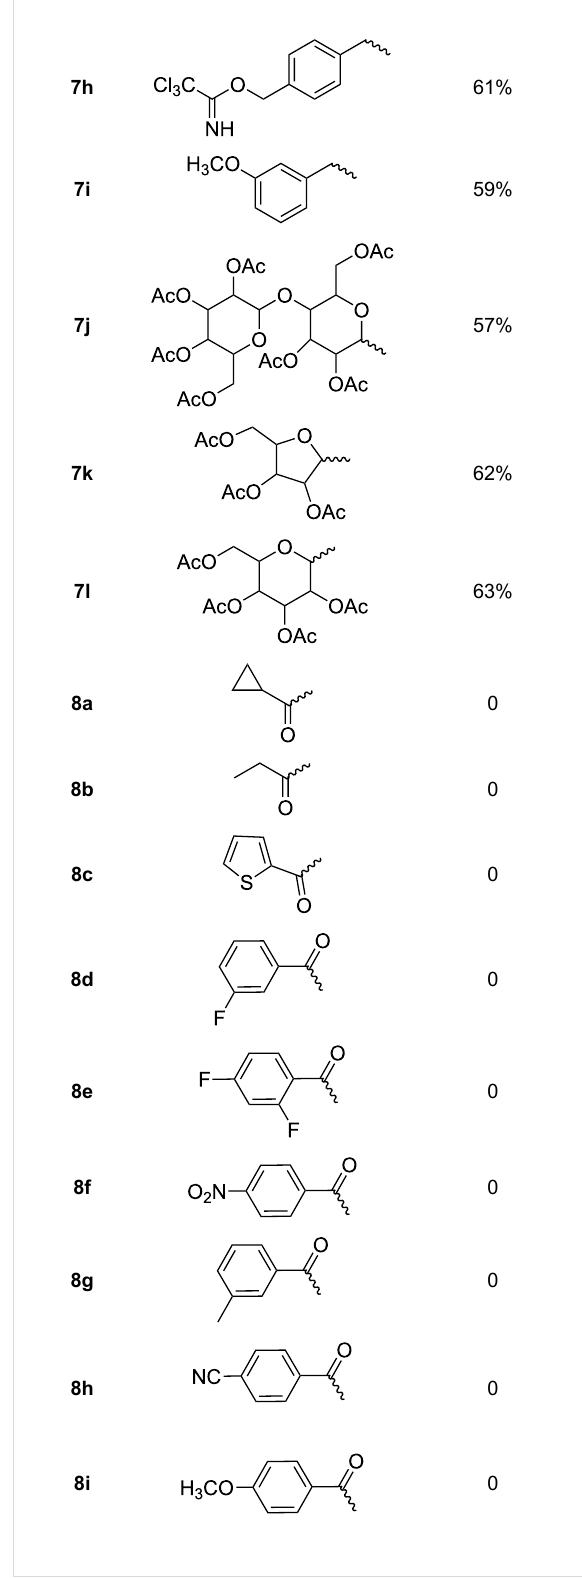
Table 1: The hydrolysis yields of spinetoram J analogues under weak acidic conditions.